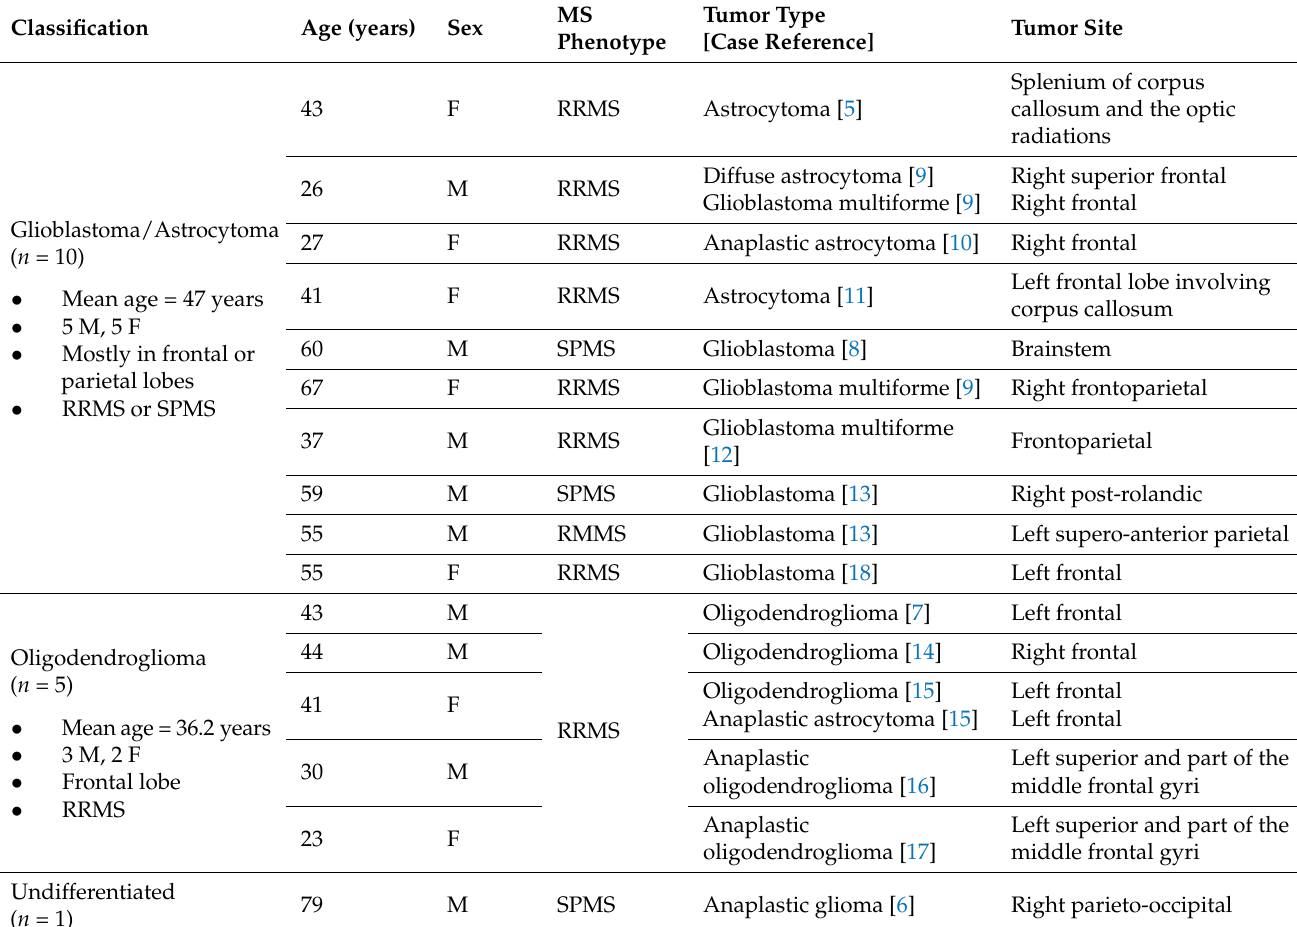
Table 2. Summary and classification of the identified glioma cases in patients with MS.